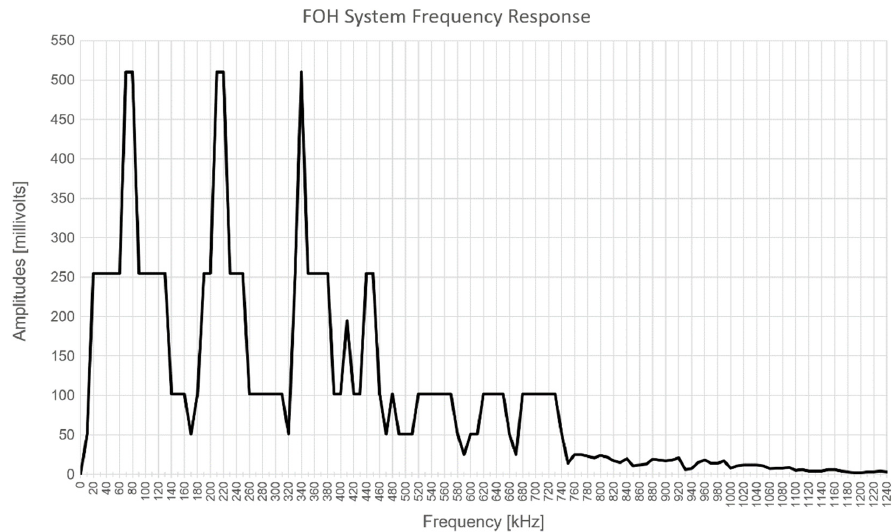
Figure 4. Experimental FOH system’s ultrasound frequency response curve.